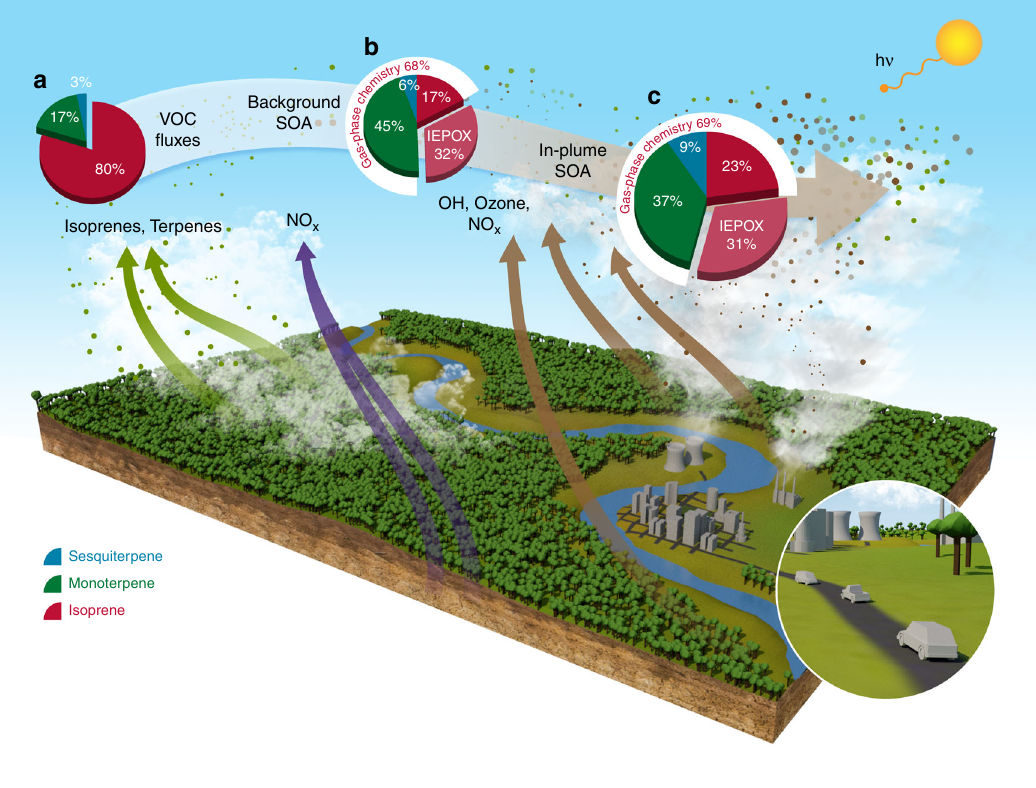
Fig. 4 Schematic illustrating how NO x emissions from Manaus greatly enhance formation of biogenic SOA within the urban plume. NO x emitted by Manaus greatly increases oxidants (OH and ozone; brown arrows), which promote reaction of forest carbon (emitted as isoprene and terpenes; green arrows). In the absence of the urban plume, background soil NO x emissions (purple arrows) drive the oxidant cycling but are much smaller than the NO x emitted from Manaus. Lower background NO x causes smaller OH and ozone production, thus decreasing reacted biogenic VOCs and SOA formation. The pie charts indicate WRF-Chem simulated domain-averaged components of a Mass emissions fl uxes of biogenic VOCs, b Background biogenic SOA and c In-plume biogenic SOA at 500 m altitude during the afternoon (16 – 20 UTC) of 13 March 2014. Biogenic SOA consists of two parts: gas-phase chemistry of isoprene, monoterpenes, and sesquiterpenes represented by VBS approach (~70% of total SOA), and multiphase chemistry that is driven by IEPOX uptake into SOA, as described in the